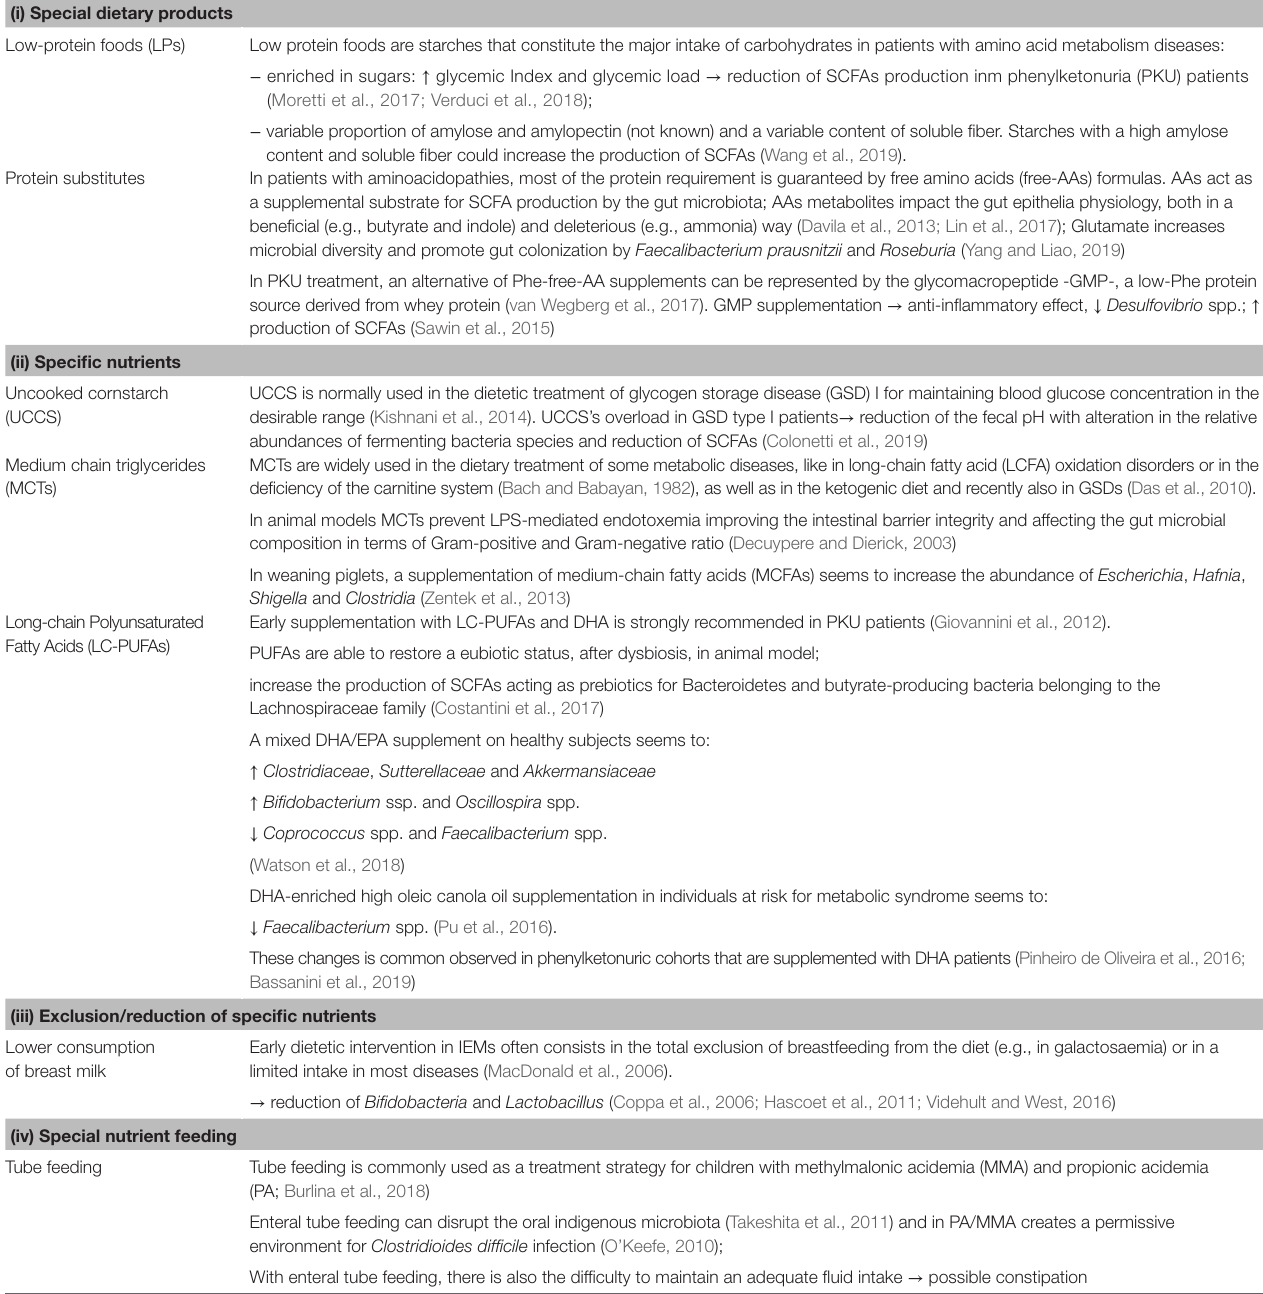
TABLE 1 | Potential effects of dietary factors on gut microbiota in IEMs. Dietary factors Potential effects on